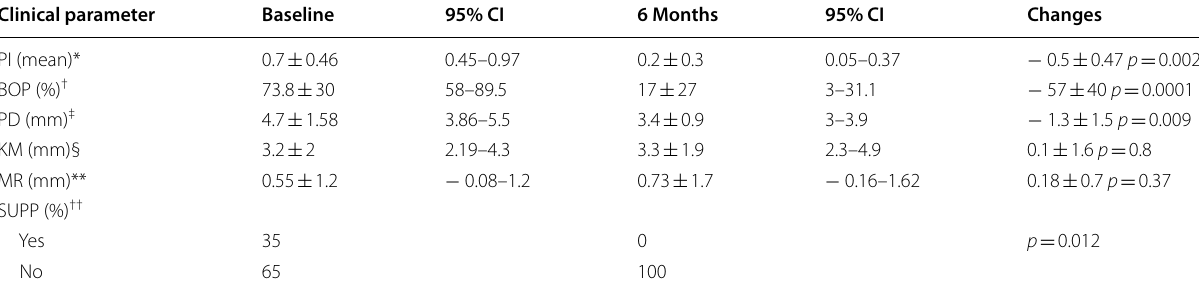
Table 2 Clinical parameters (mean, SD, confidence interval and difference values) before surgical procedure and after a 6 month follow‑up period (patient level) ( n 14). * p < =